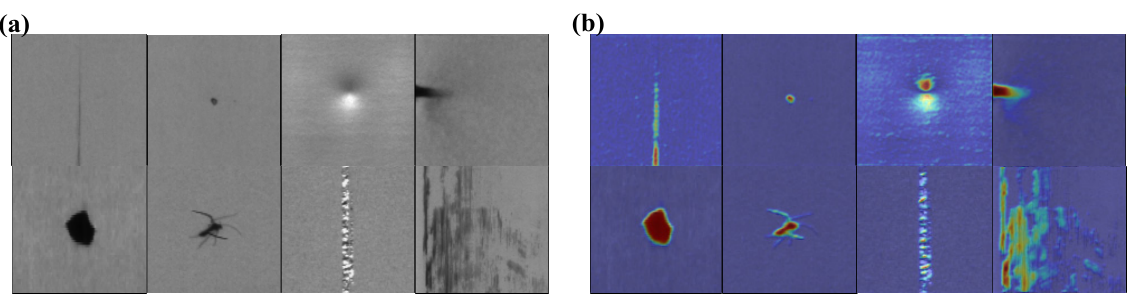
Figure 12. Class activation maps of surface defects localised by the proposed model: ( a ) original defect image; ( b ) class activation maps.